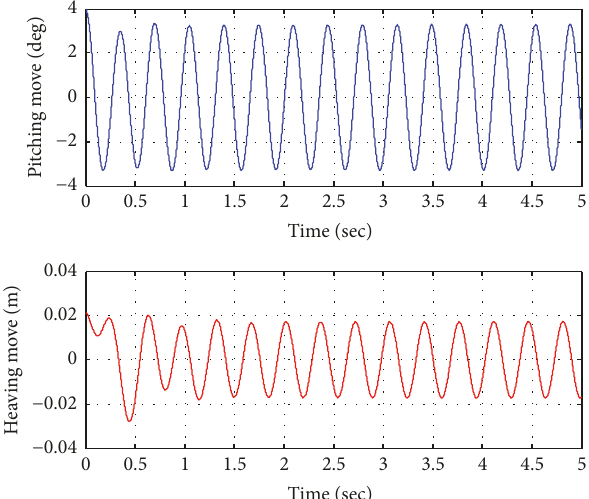
Figure 9: Open-loop responses (limit cycle) in pitch and plunge oscillation amplitude versus time for two-dimensional wing, in degree and meter, respectively.